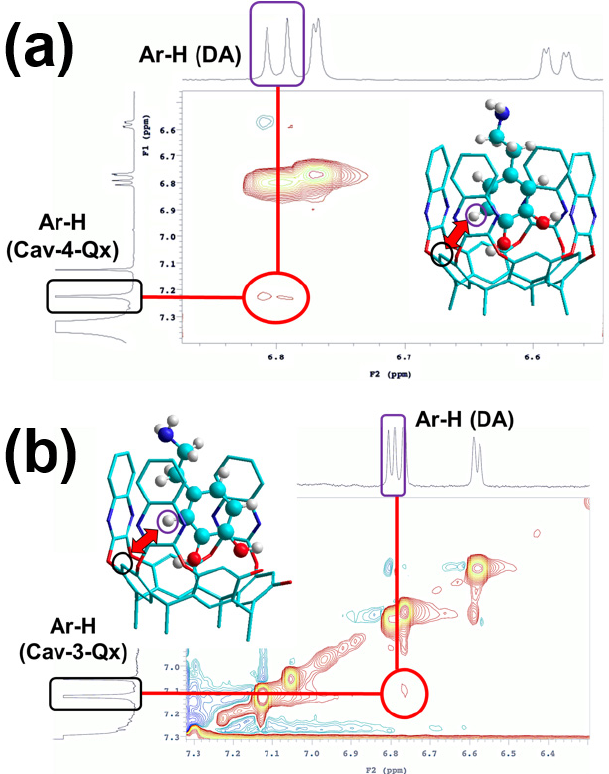
Figure 2. Detail of ROESY spectra of ( a ) Cav-4-Qx and DA and ( b ) Cav-3-Qx and DA in CDCl 3 /CD 3 OD (6/1) ((Host) = (DA) = 1 × 10 − 3 M); insets show the minimized structure (force field MM+) of the supramolecular complexes, highlighting the functional groups involved in the ROE contacts (host signals are shown in black, DA is highlighted in violet, hydrogens of the hosts are omitted for clarity).